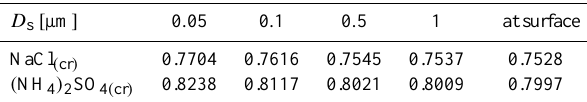
Table 3. Estimated ∗ RHD values for different D s